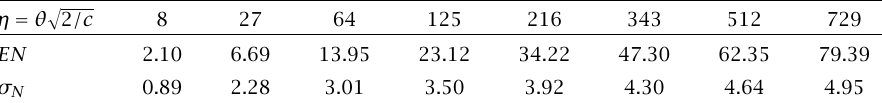
Table 3.1 . Exact values of EN and σ N for selected values of η